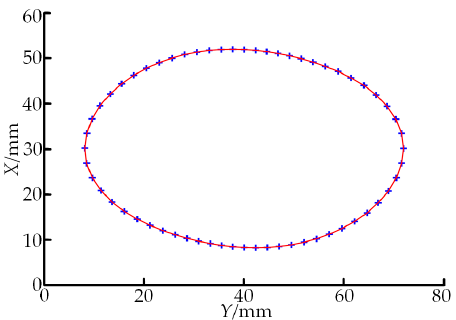
Figure 13. Profile of double-headed screw rotor after smoothing and fitting through the method in Section 2.3.